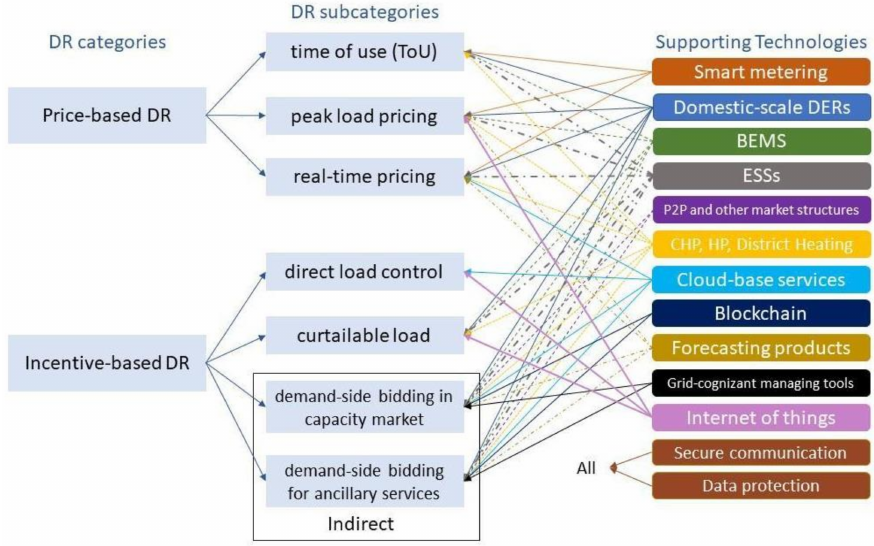
Figure 2. Classification of DR programs and supporting